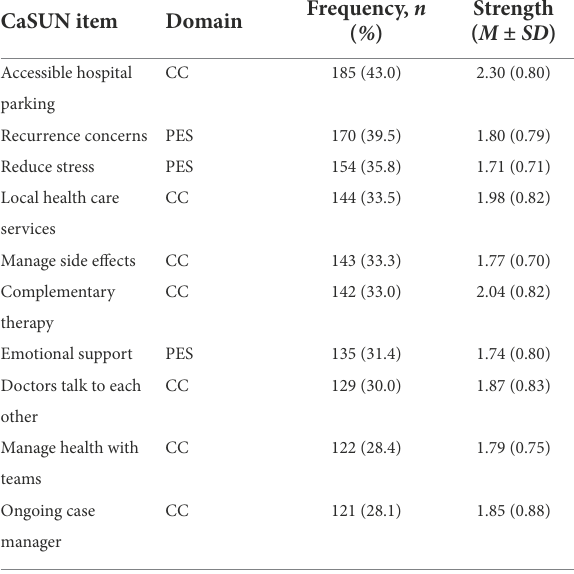
TABLE 2 Ten most frequently reported unmet needs and its strength.